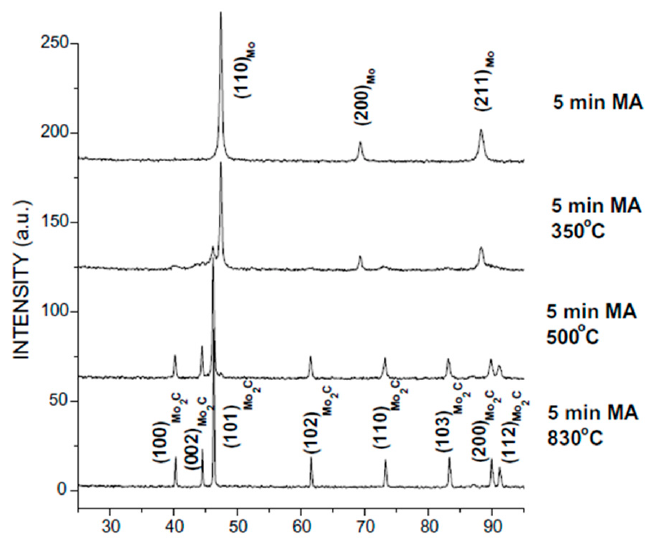
Figure 9. XRD patterns (Co K α irradiation) of molybdenum–amorphous carbon mixtures after HEBM for 5 min and annealing at 350, 500 and 830 °C. Reprinted from [41], Copyright (2004), with permission from Elsevier.